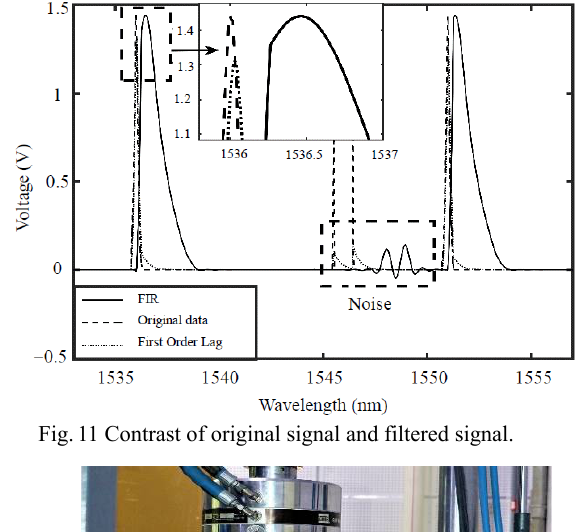
Fig. 11 Contrast of original signal and filtered signal.